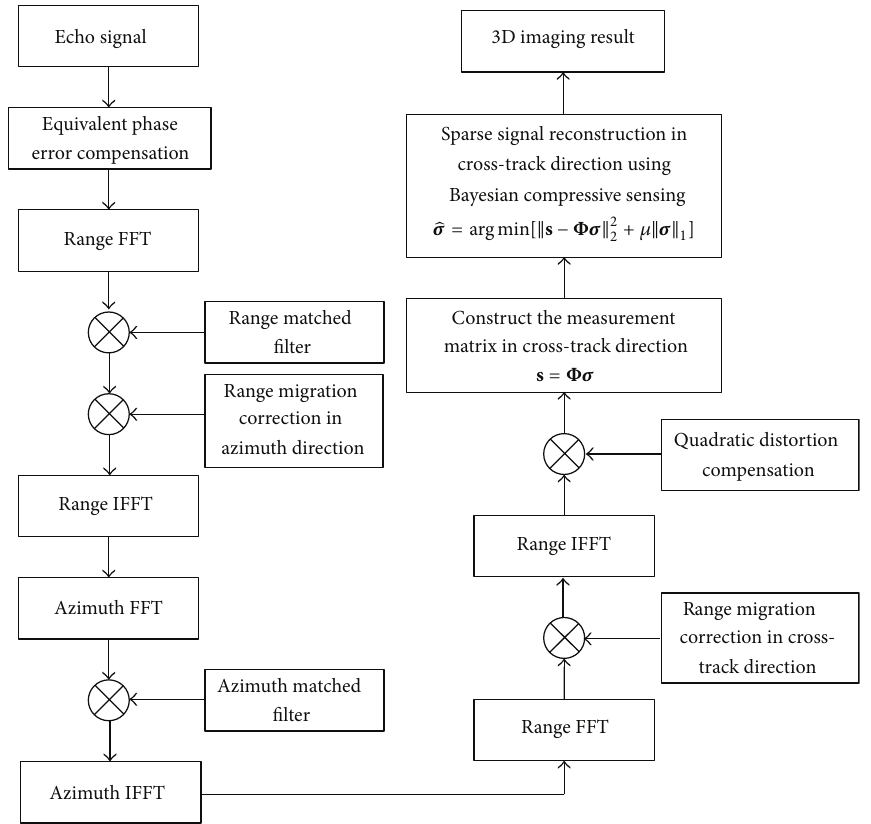
Figure 3: The flowchart of proposed method for down-looking MIMO array SAR imaging.